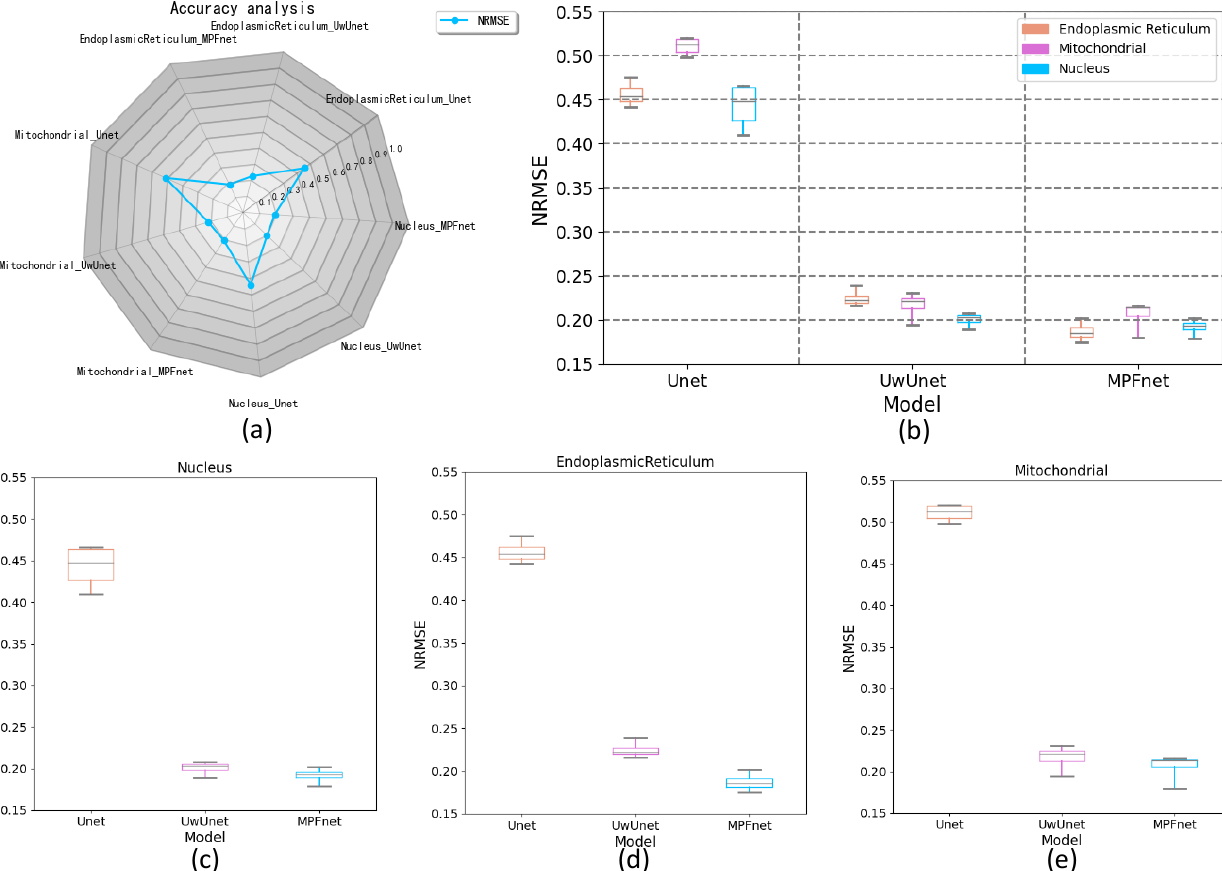
Figure 8. Comparing NRMSE performance among various prediction algorithms. ( a ) NRMSE radar chart for quantitative comparisons of different predictive models. ( b ) Box plot of NRMSE value over all organelles (nuclei, mitochondria, and endoplasmic reticulum) prediction task set with MPFnet-based learning model and compared with that of varied deep neural network-based prediction models such as Unet and UwUnet learning models. ( c ) Box plot of NRMSE value on nuclei prediction task set with MPFnet-based learning model and compared with that of varied deep neural network-based prediction models such as Unet and UwUnet learning model. ( d ) Box plot of NRMSE values on endoplasmic reticulum prediction task set with MPFnet-based learning model and compared with that of varied deep neural network-based prediction models such as Unet and UwUnet learning model. ( e ) Box plot of NRMSE values on mitochondria prediction task set with MPFnet-based learning model and compared with that of varied deep neural network-based prediction models such as Unet and UwUnet learning model.